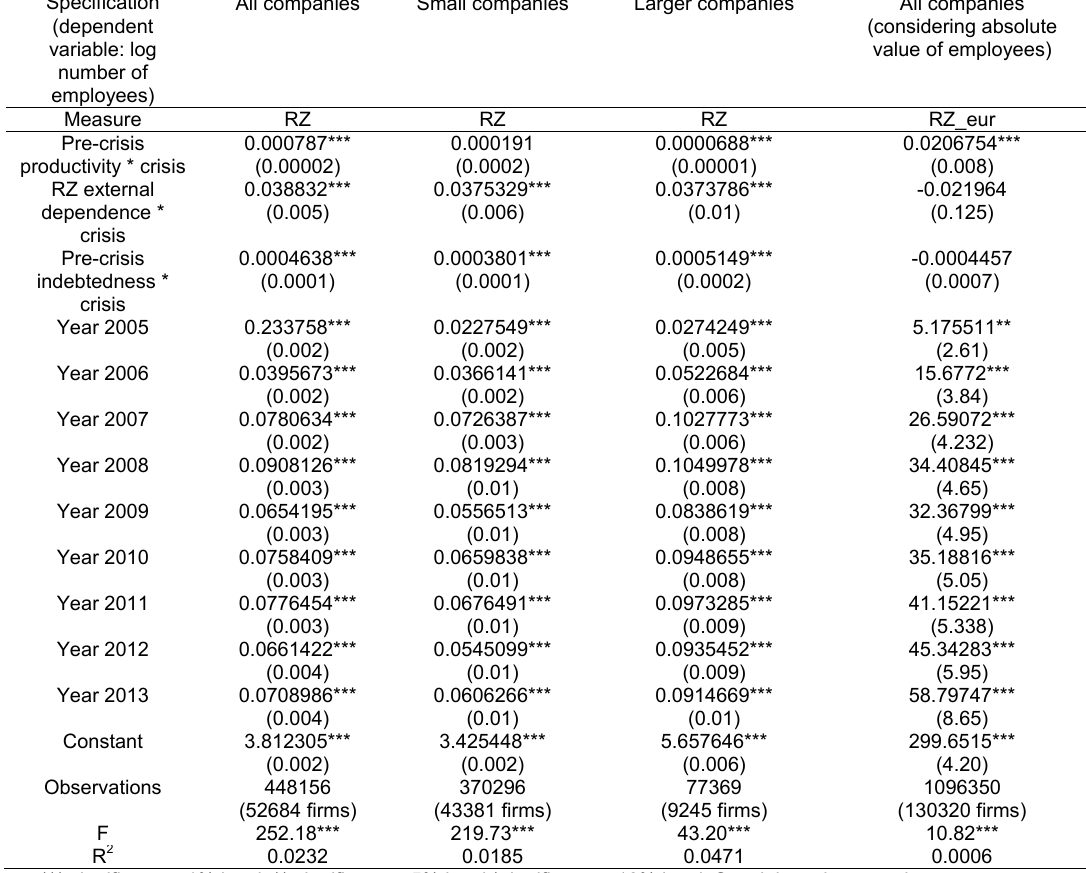
Table A.1. Other functional specifications for the main regression: RZ coefficient, absolute values.